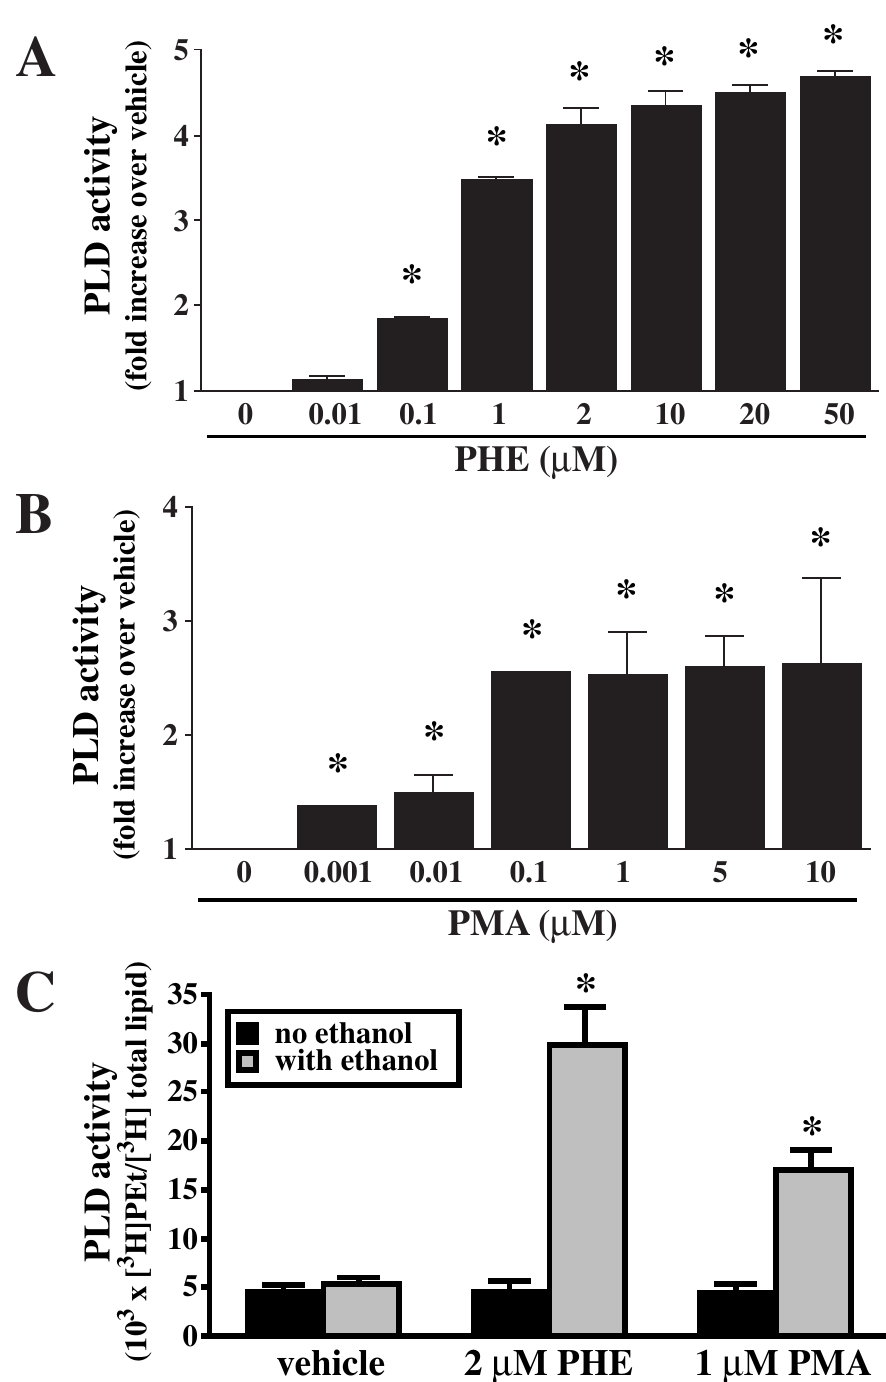
Figure 1 Phospholipase D (PLD) activity is stimulated by phenylephrine (PHE) and PMA in rat-1 fibroblasts. Cells in serum-free DMEM were incubated overnight with 1 µ Ci/ml [ 3 H]oleic acid, pretreated with 200 mM ethanol (A, B) or with or without ethanol (C) for the measurement of phosphatidylethanol (PEt) formation, and finally treated with different concentra- tion of PHE (A, basal = 7.09 ± 2.68 × 10 3 × [ 3 H]PEt / [ 3 H]total lipids) or PMA (B, basal = 6.81 ± 2.07 × 10 3 × [ 3 H]PEt / [ 3 H]total lipids) for 15 min. Data are expressed as the ratio of [ 3 H]PEt over [ 3 H]total lipids. Values are the mean ± S.E. of three inde- pendent experiments performed in duplicate. * Value significantly different from vehicle, p <